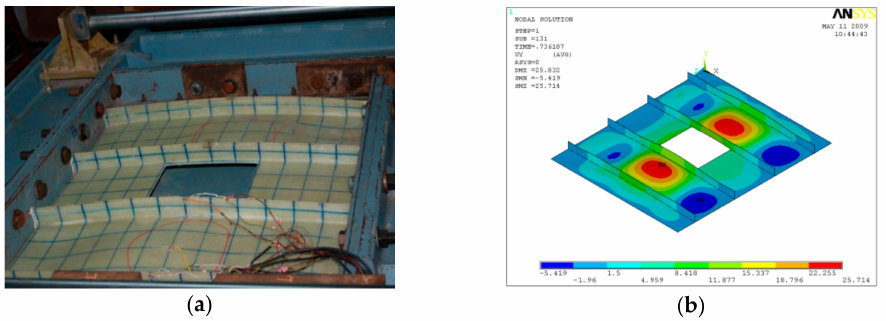
Figure 12. Buckling of LSTPO1 ( a ) Experiment ( b )